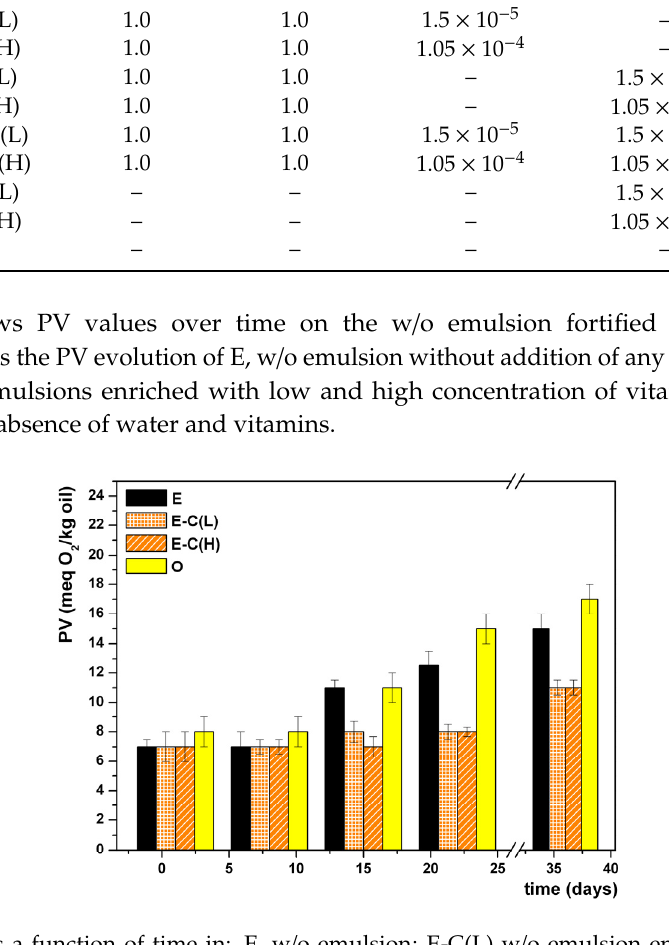
Scheme 1. Schematic representation of emulsion preparation for the peroxide values (PV)